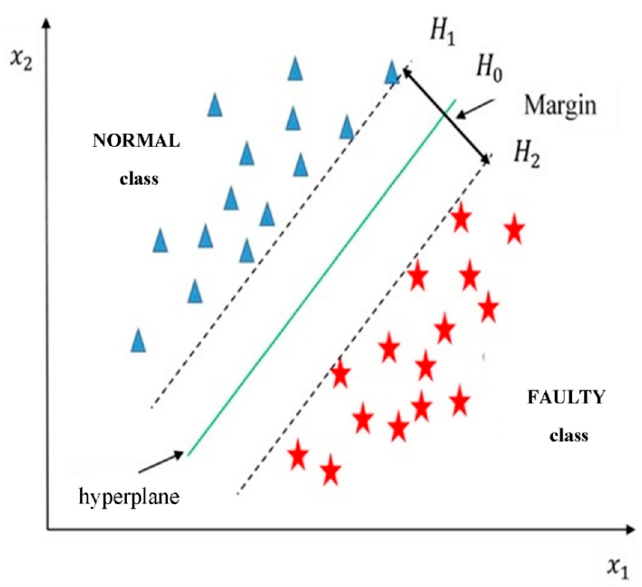
Figure 5. Example of a linear classifier for a two-class problem